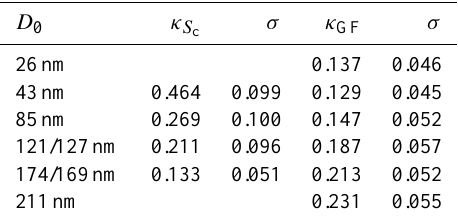
Table 2. κ values for both HTDMA and CCN data, split by an organic:sulphate ratio of ≤ 4:1. D 0 is particle dry diameter and σ is the standard deviation.